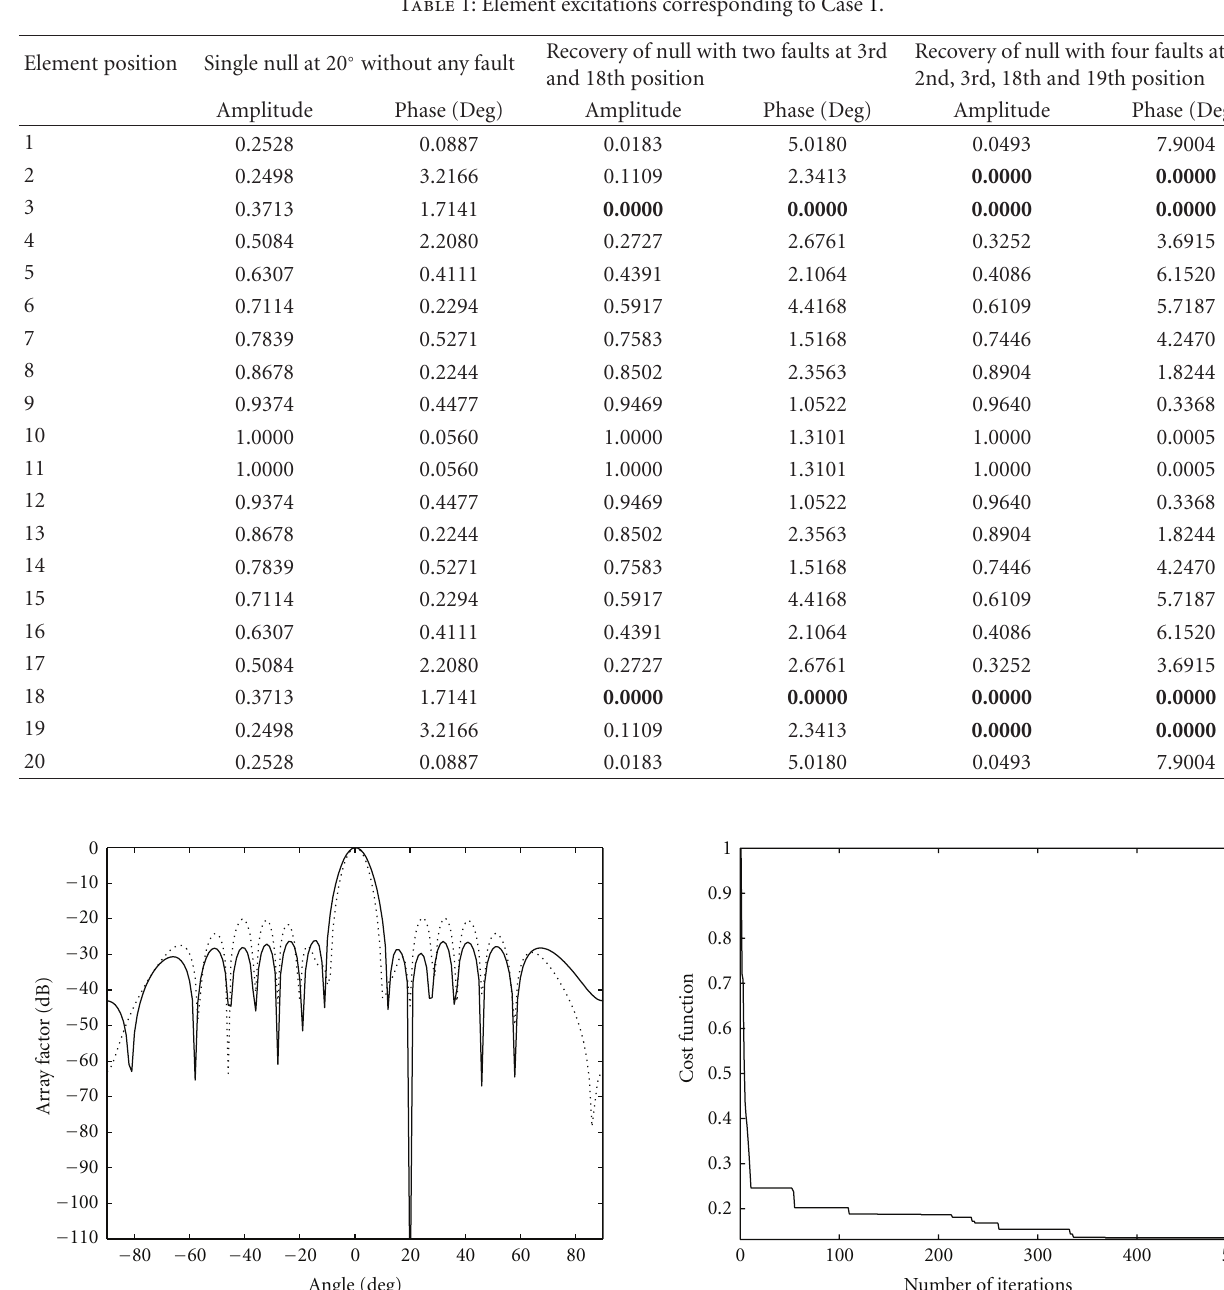
Figure 3: Radiation pattern for 3rd and 18th element failure with main beam at broadside. Dotted line curve shows the damaged array pattern and the solid line curve shows the corrected pattern.